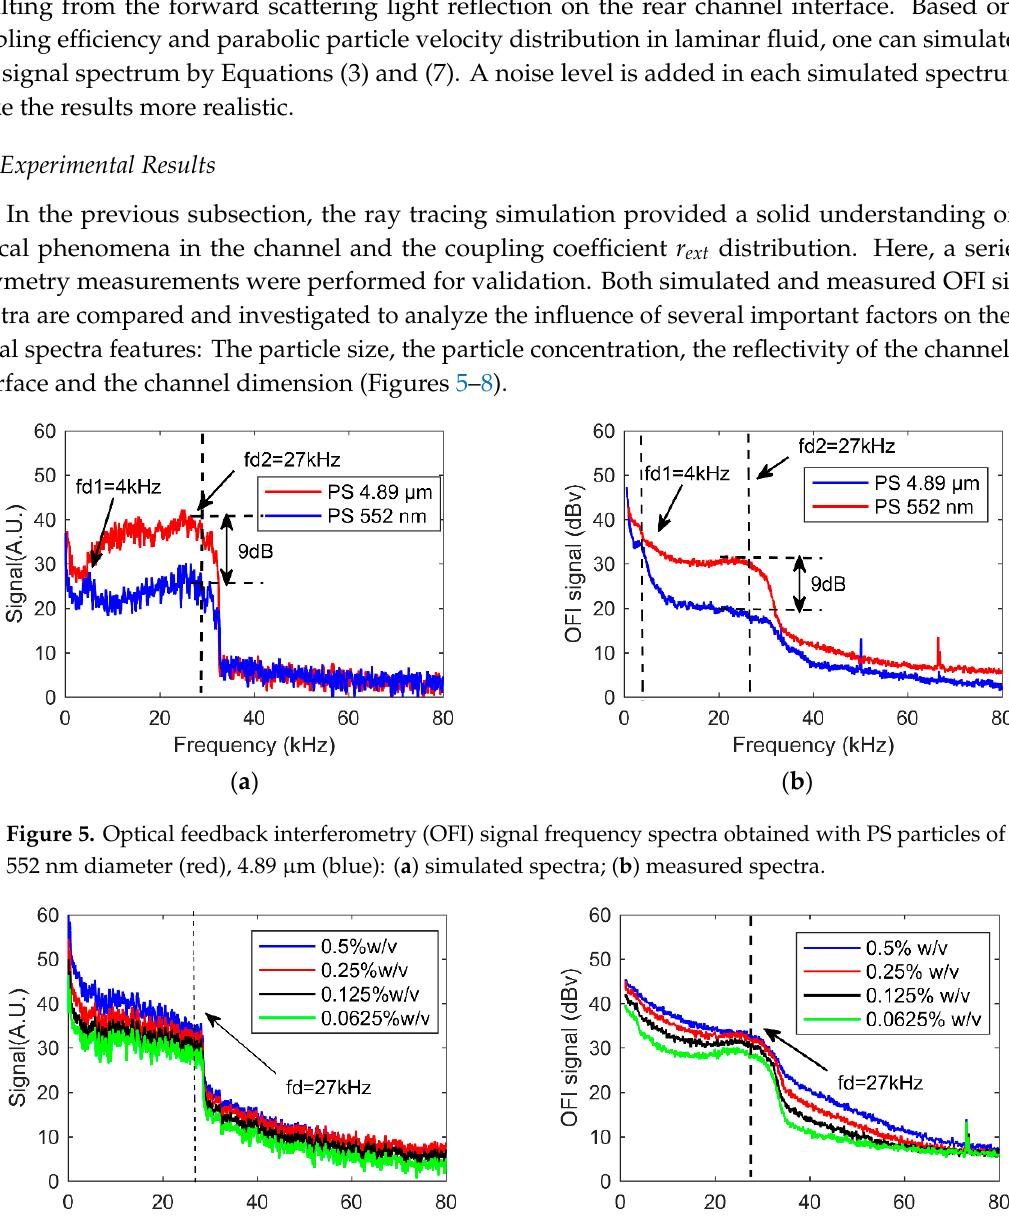
Figure 6. OFI signal frequency spectra obtained in 552 nm PS particle solution at concentration of 0.625% w/v (green), 0.125% w/v (black), 0.25% w/v (red), 0.5% w/v (blue): ( a ) simulated spectra; ( b ) of 0.625% w / v (green), 0.125% w / v (black), 0.25% w / v (red), 0.5% w / v (blue): ( a ) simulated spectra; measured spectra. ( b ) measured